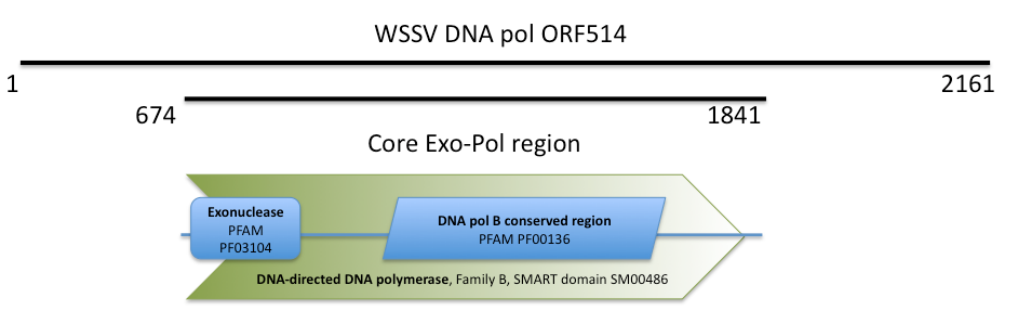
Figure 1. Domain structure of the core region of the WSSV ORF514. The domains identified in the sequence include the reference number either to the PFAM (http://pfam.sanger.ac.uk) or SMART (http://smart.embl-heidelberg.de) domain.